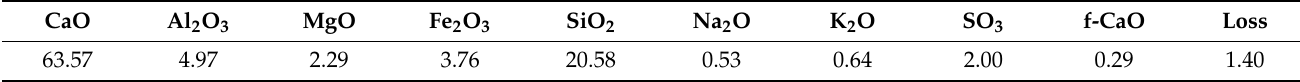
Table 2. Chemical composition of cement (wt%).